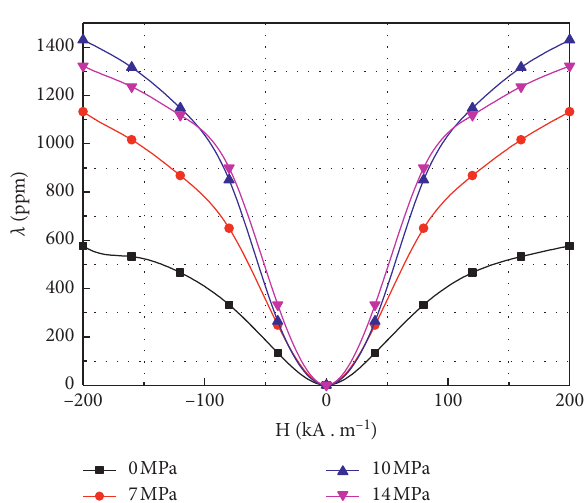
Figure 2: Magnetic field intensity-magnetostrictive coefficient